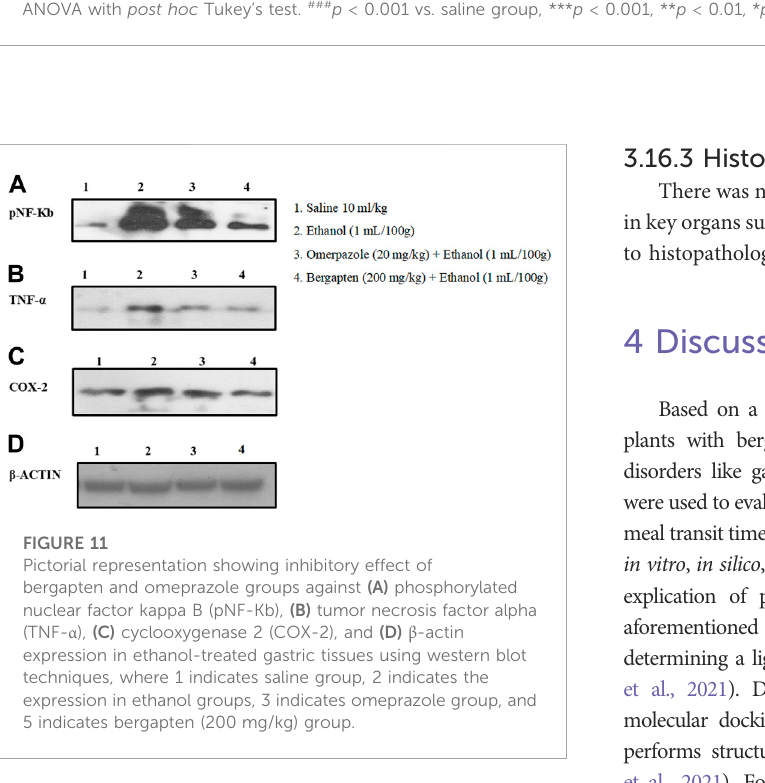
FIGURE 10 Effect of bergapten and omeprazole on (A) TNF- α (tumor necrosis factor alpha), (B) IL-8 (interleukin-8), and (C) PGE 2 (prostaglandin-E 2 ) expressioninwoundhealingintheethanol-inducedgastriculcermodelexaminedbyELISA.Thedataareexpressedasmean±SEM( n =3).One-way